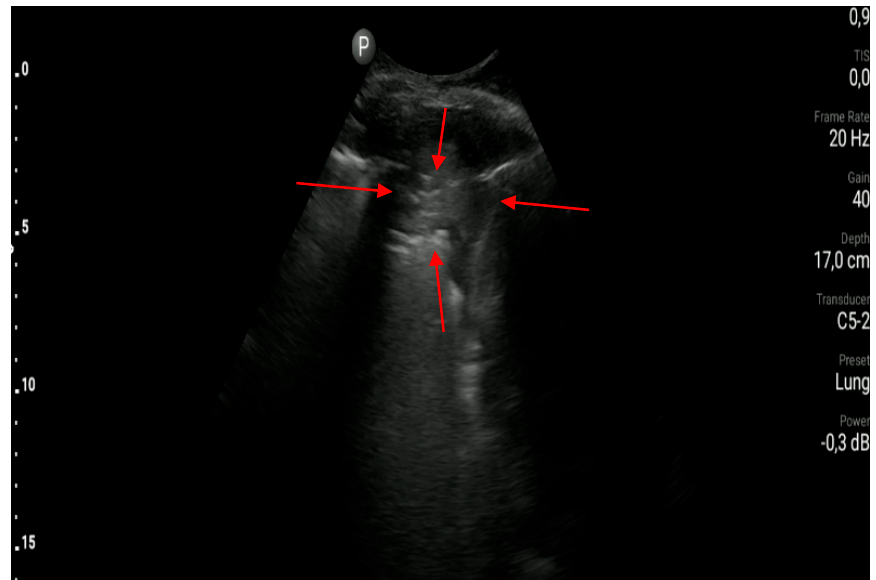
Figure 7. Subpleural consolidation (between red arrow).